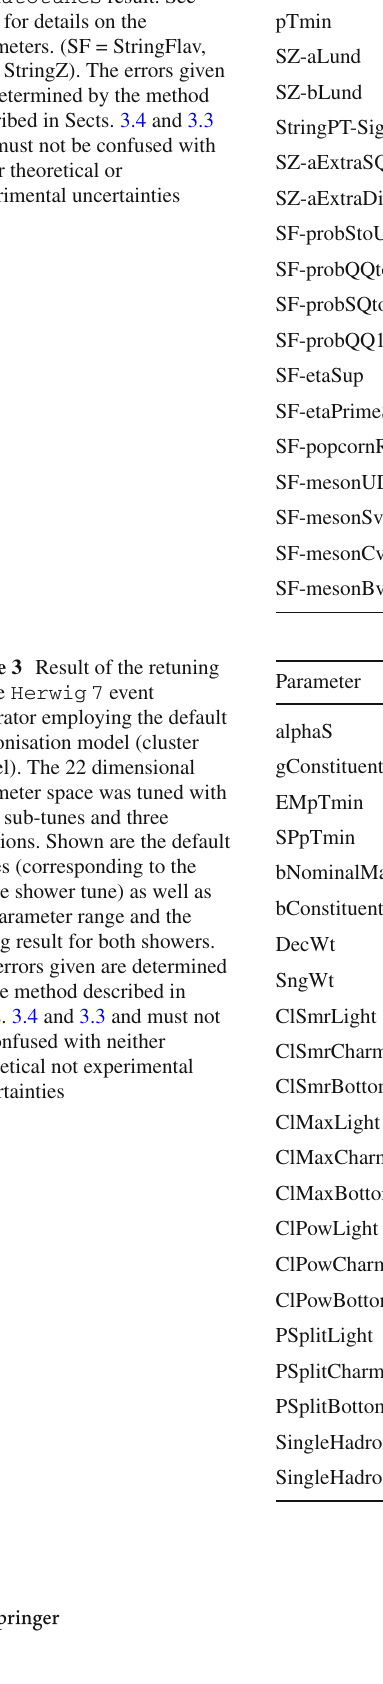
parameters with default values, initial ranges for the tune, and the Autotunes result. See [7,8] for details on the parameters. (SF = StringFlav, SZ = StringZ). The errors given are determined by the method described in Sects. 3.4 and 3.3 and must not be confused with